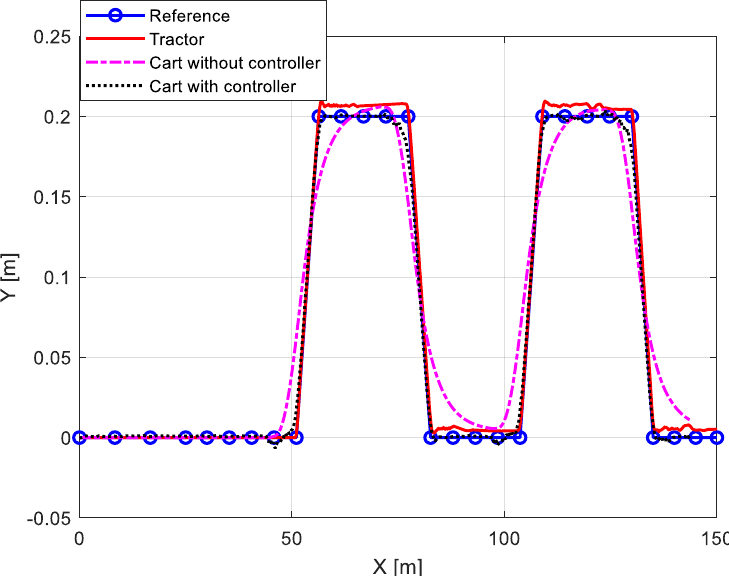
Figure 11. Performances of tractor-cart position control system under a sinusoidal pattern at 1 [m / s].